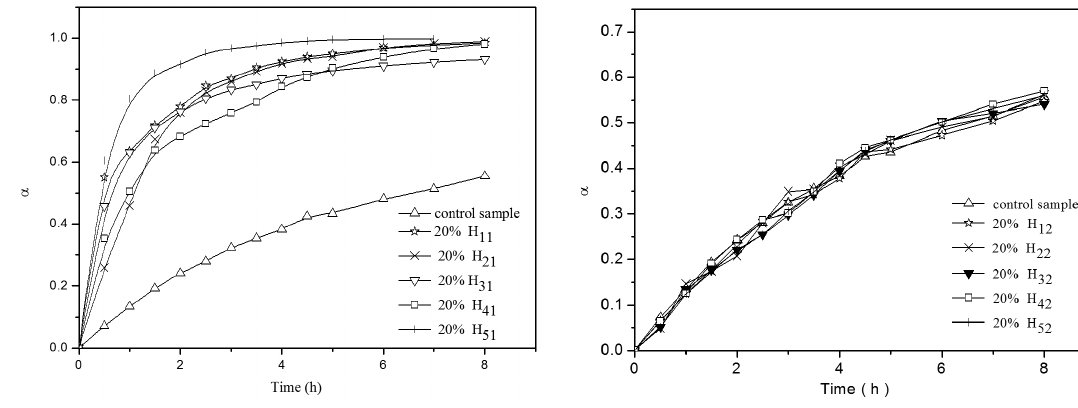
Figure 2. Conversion-time curves for the control sample and H-IPNs with 20 wt% different generation of SHPE.